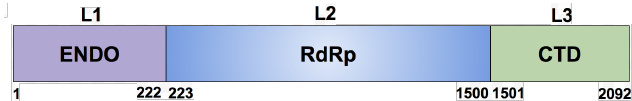
Figure 3. Three domains and boundary determination of RVFV L protein structural